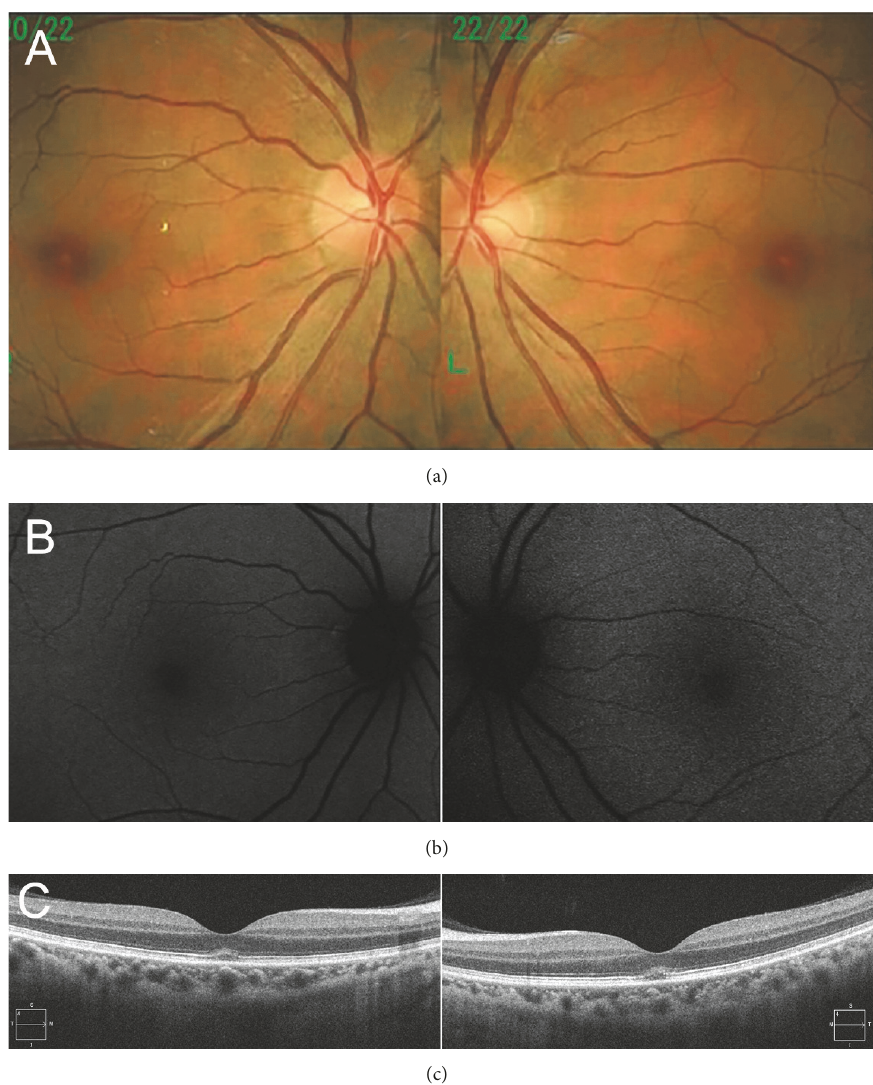
Figure 1: Fundus photographs, fundus autofluorescence imaging (FAF), and optical coherence tomography (OCT) images obtained during the first examination. (a) Fundus photograph showed a tiny, yellowish spot in the bilateral fovea. (b) FAF showed no abnormalities in either of the eyes. (c) OCT showed a diffused and elevated ellipsoid zone and disrupted interdigitation zone in both foveal